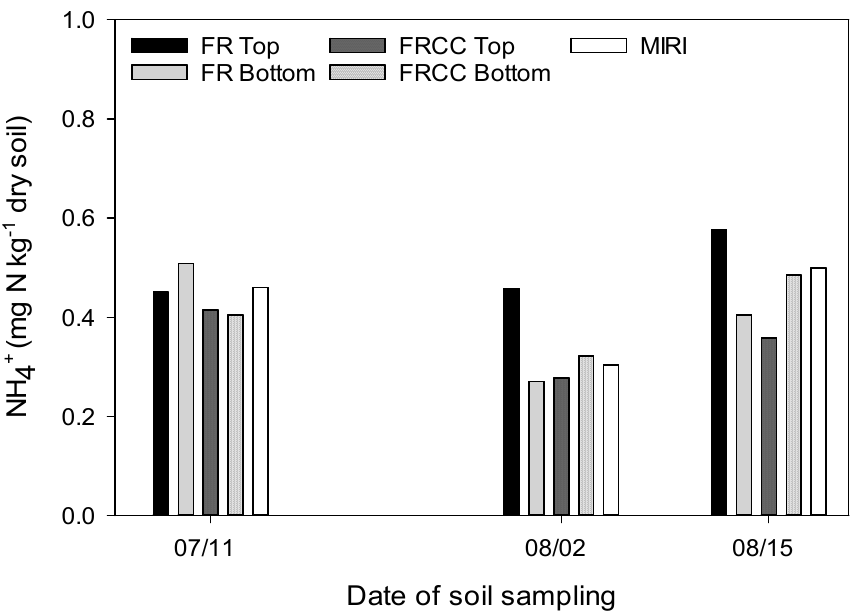
Figure 1. Soil ammonium (NH 4+ ) concentration from top and bottom sections of furrow rice (FR), furrow rice with cover crops (FRCC) and multiple inlet rice irrigation (MIRI) at various sampling dates during the study period.